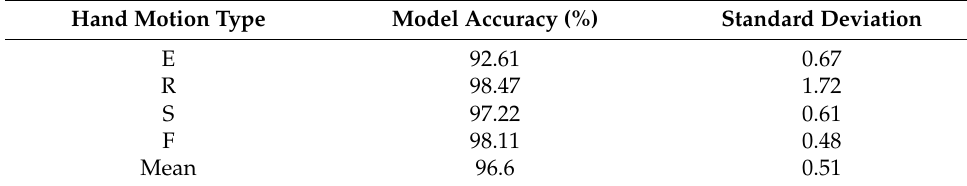
Table 3. The average accuracy of the neural network model across four subjects.